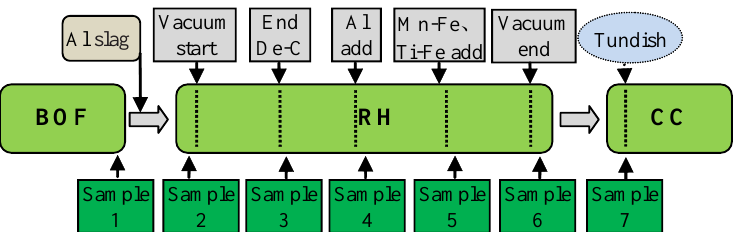
Figure 1. Schematic of charging and taking specimens during steelmaking processes